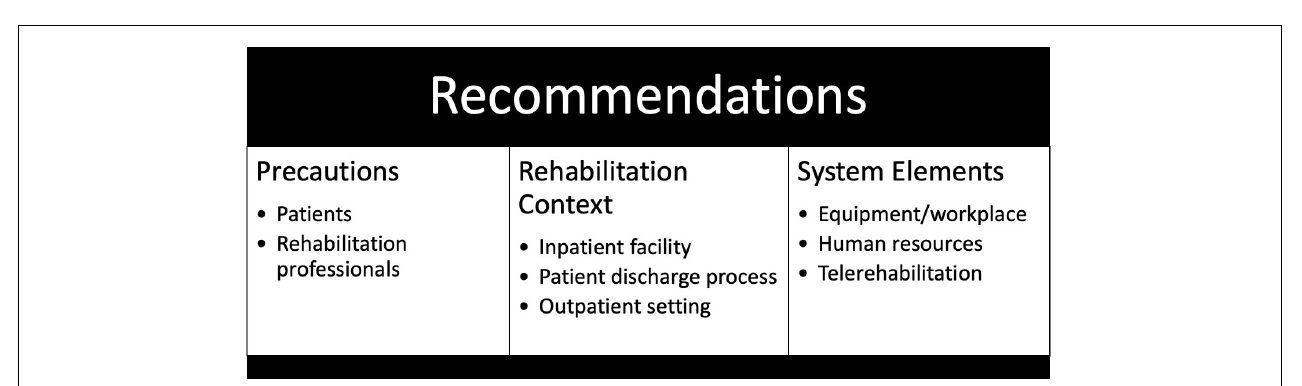
FIGURE 3 | Structure of health system